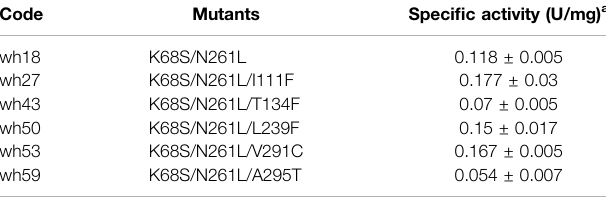
TABLE 2 | Speci fi c activity of Sp AmDH mutants toward substrate